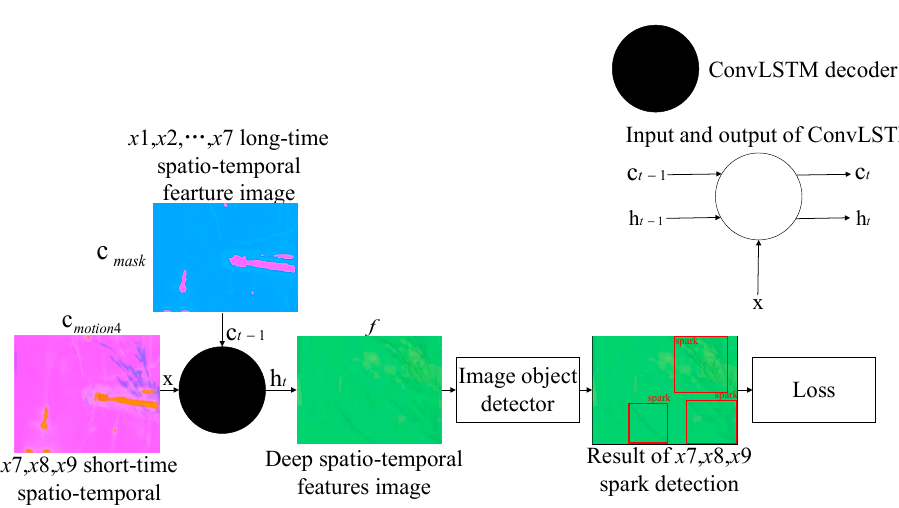
Figure 5. The proposed scene encoding model.